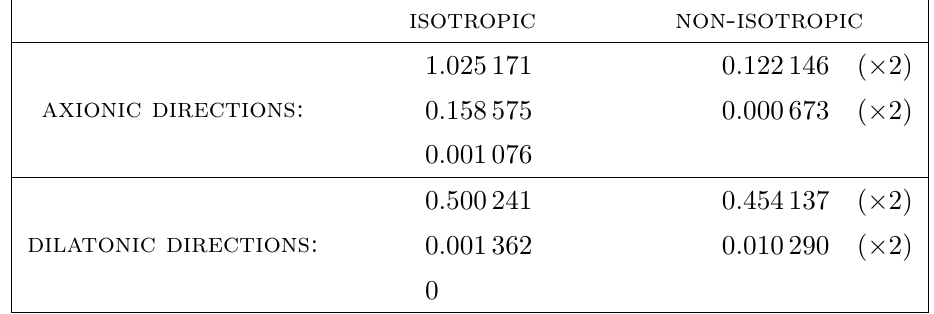
JK D I D K V j sol : . Note that the K